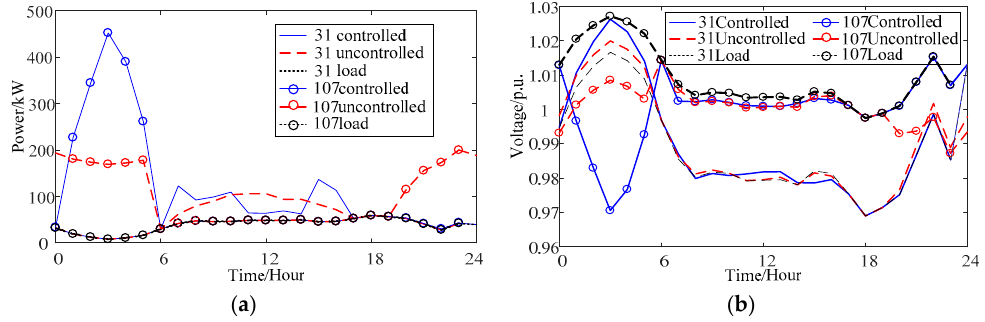
Figure 7. Load and voltage profiles at bus 31 phase-C and bus 107 phase-B: ( a ) Load profiles at ff erent buses with and without EV charging control. different buses; ( b ) voltage profiles at different buses with and without EV charging control. buses; ( b ) voltage profiles at di